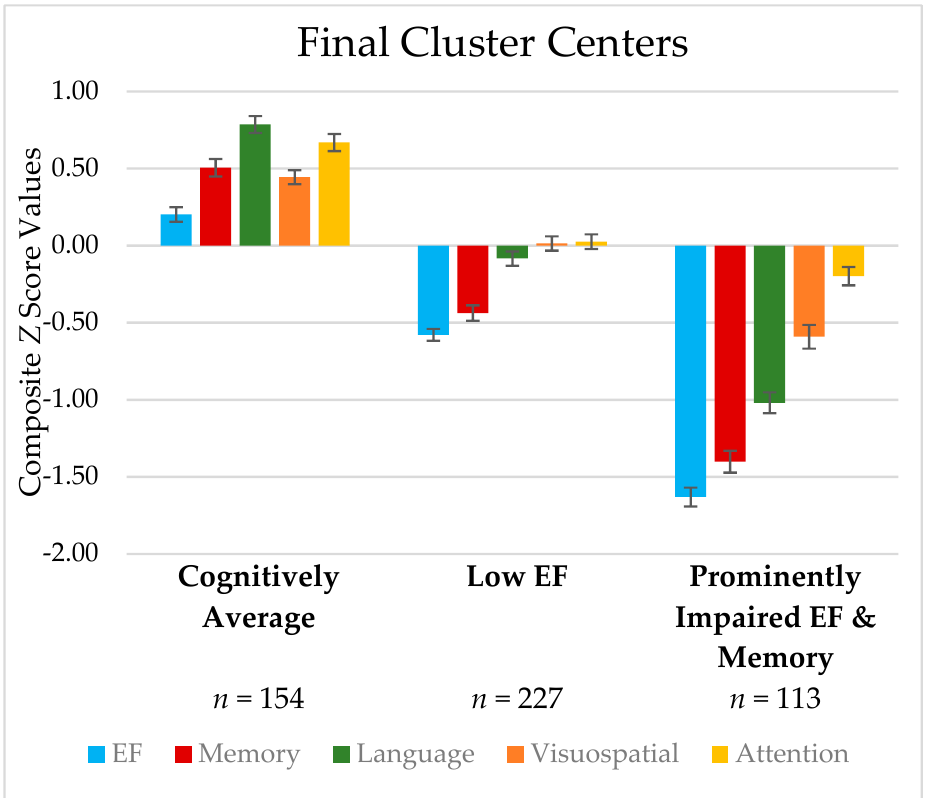
Figure 2. K-Means 3 cluster solution based on pattern of cognitive domain performance. Note . Error bars reflect the standard error of each metric. EF = Executive Function.